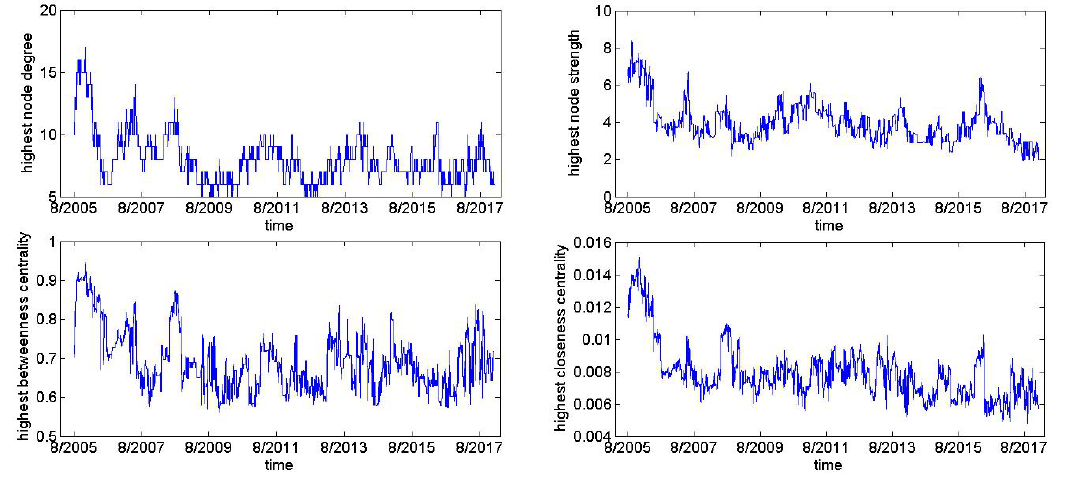
Figure 10. The highest centrality measures in the FX